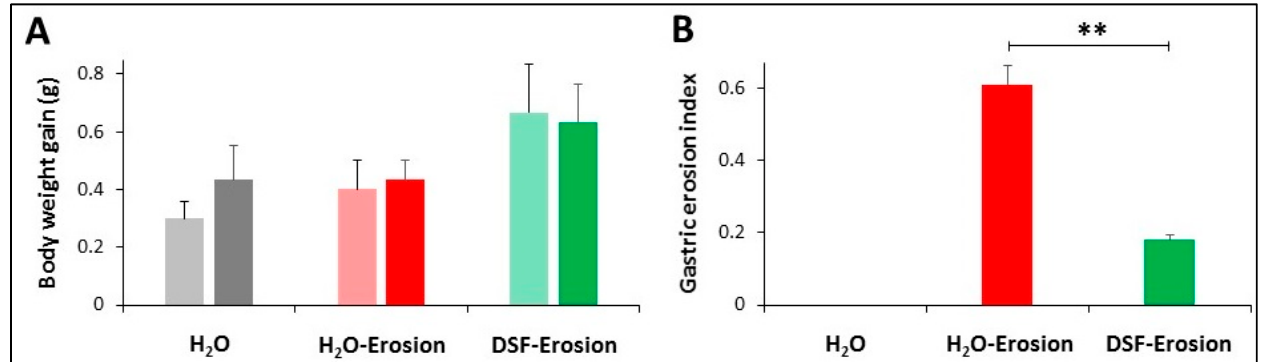
Figure 2. Body weight gain ( A ) and gastric erosion index ( B ) in control (H 2 O), erosion-induced, and DSF-pretreated then, erosion-induced mice. The body weight gain was measured after 6 and 11 days of starting the experiment. Data from 3 mice in each group are presented as mean ± SE. Differences in body weight gain among the three groups of mice were not statistically significant. Gastric erosion index is reduced in mice given DSF for 10 days and then ASA-containing ethanol on day 11. This reduction was statistically significant when compared with the erosion-induced group (** p <0.01). Data are presented as mean ± SE.